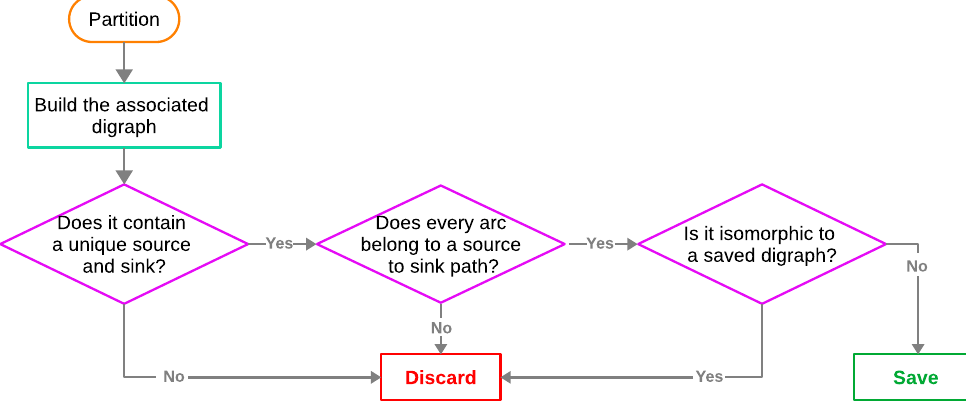
Figure 6. Sketch of the filter algorithm.